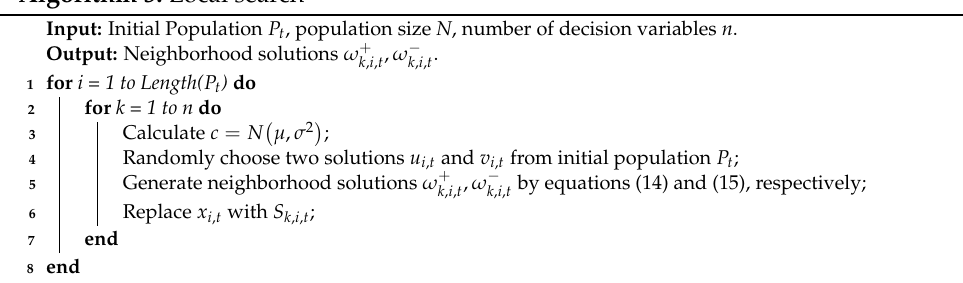
Algorithm 3: Local search